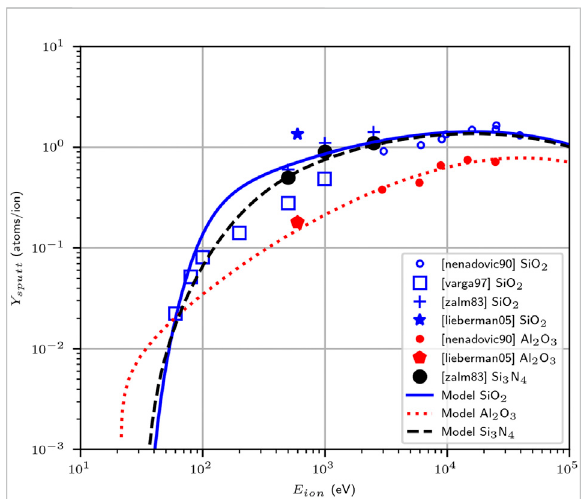
FIGURE 5 Estimation of the sputtering yield at normal incidence for argon ions impacting on different dielectric ceramic materials commonly used in HPSs, obtained from the model presented in Section 2.4. The fi tting parameters used are those described in Table 4. The estimations are compared to the